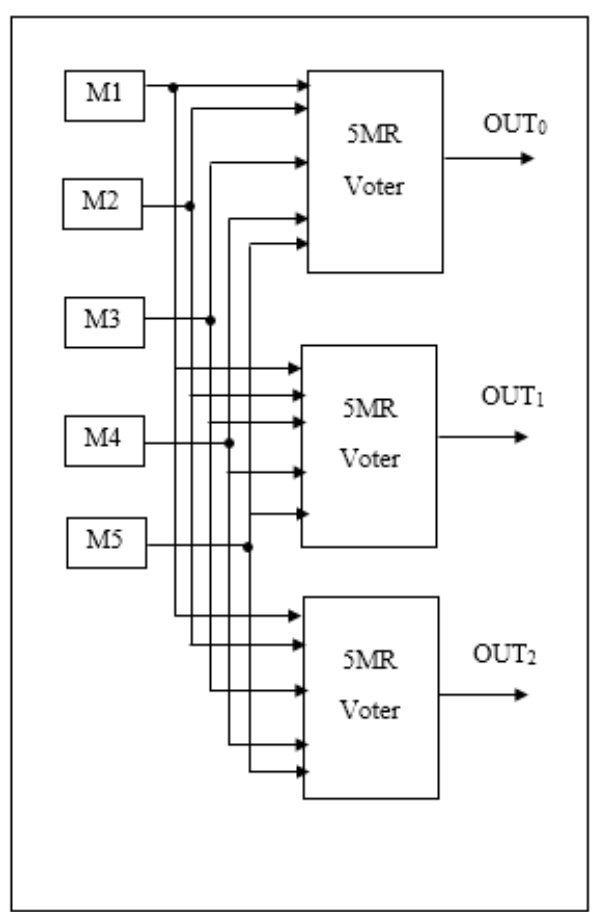
Figure 9. Fault secure design-based FPGA.